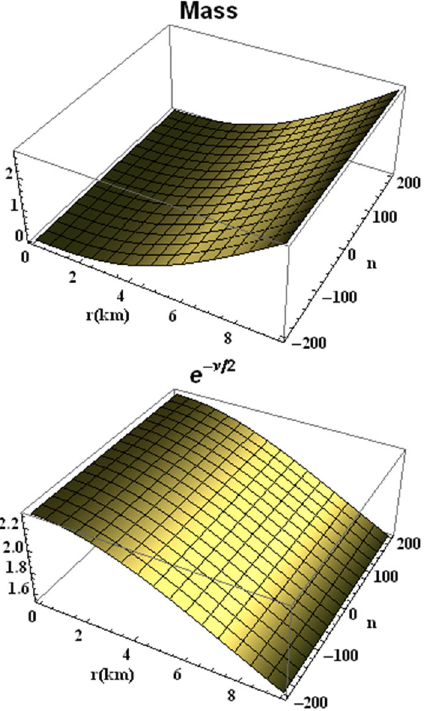
Fig. 4 (Top) Along x -axis, y -axis and z -axis we have respectively plot- ted the radius of the star in km unit, the dimensionless quantity n which lies in the range − 200 ≤ n ≤ 200 and mass of the star in km unit. (Bottom) Along x -axis, y -axis and z -axis we have respectively plotted the radius of the star in km unit, the dimensionless quantity n which lies in the range − 200 ≤ n ≤ 200 and the gravitational redshift which is also a dimensionless quantity. Both the profiles are drawn for a compact star of mass M = 1 . 85 M (cid:3) and radius of the star = 9 . 5km by fixing b = 0 . 0095 km −